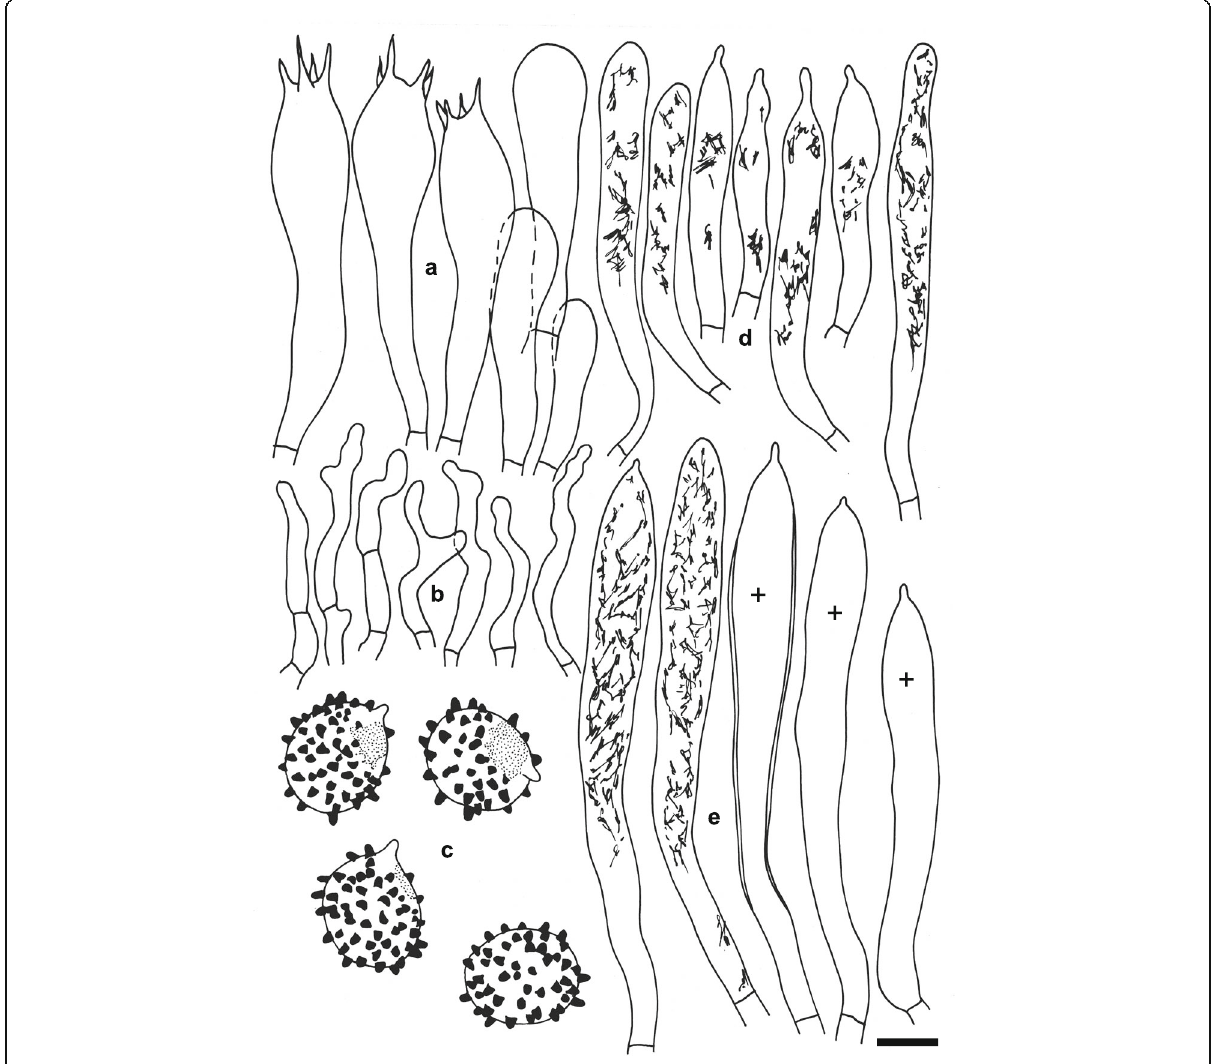
Fig. 7 Russula tengii (HMAS262728, holotype). Microscopic features of the hymenium. a. Basidia and basidiola. b. Marginal cells. c. Basidiospores in Melzer ’ s reagent. d. Cheilocystidia. e. Pleurocystidia. Contents of cystidia are represented as observed in Congo red; crosses schematically indicate the contents of some cystidia. Bars = 10 μ m, spores = 5 μ m. Drawings: S.A. &